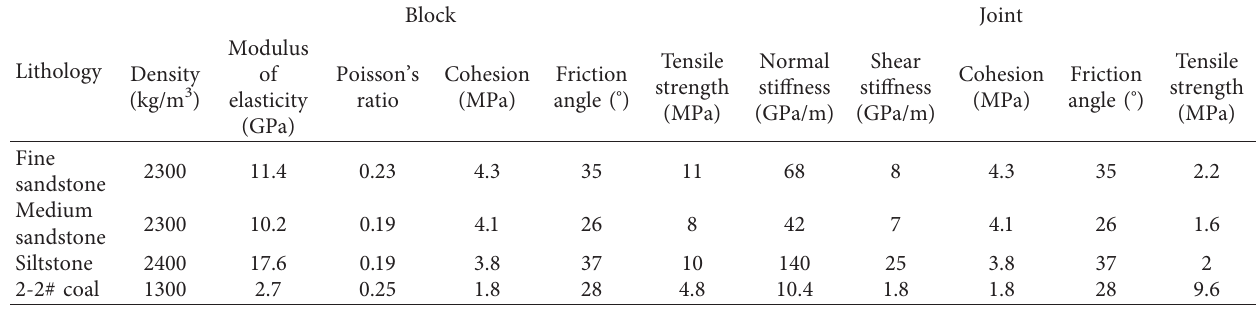
Table 4: Parameter check process of blocks and joints.